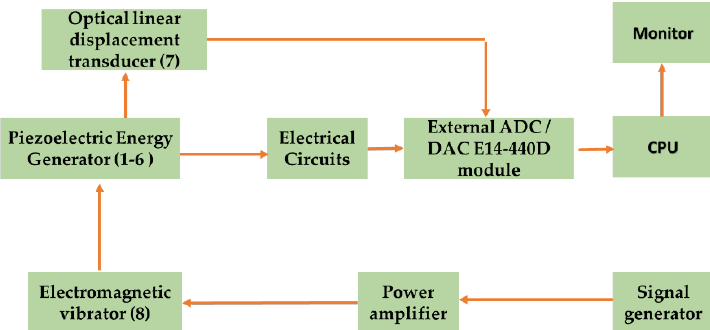
Figure 2. Schematic diagram of the experimental setup.